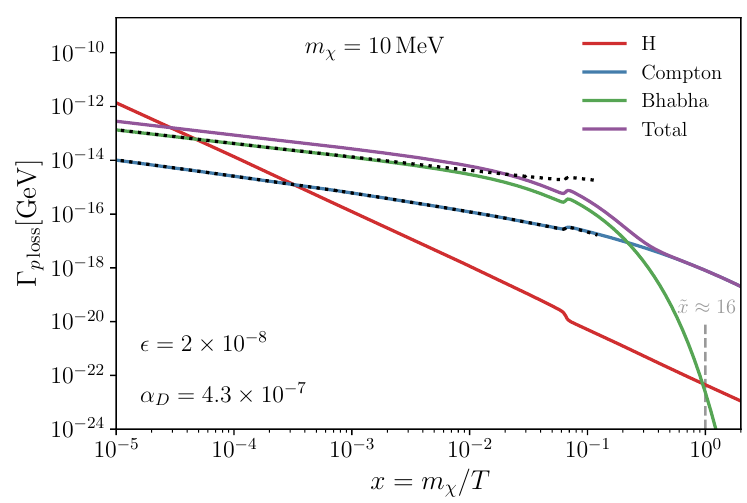
Figure 5 . Momentum loss rate due to various scattering processes compared to the Hubble rate. Here, we are accounting for the non-adiabatic evolution of the hidden sector temperature in evalu- ating the rates. The parameters used are the same as the yellow point in figure 2, with ξ and m = 10 − 15 eV. The Bhabha and Møller rates are identical so for clarity we only show one Z D curve. Finally, the black dotted lines are the semi-analytical solutions for the rates for T (cid:29) m and the gray dashed line is the value of ˜ x at x = 1 to illustrate the Boltzmann suppression for the Bhabha and Møller